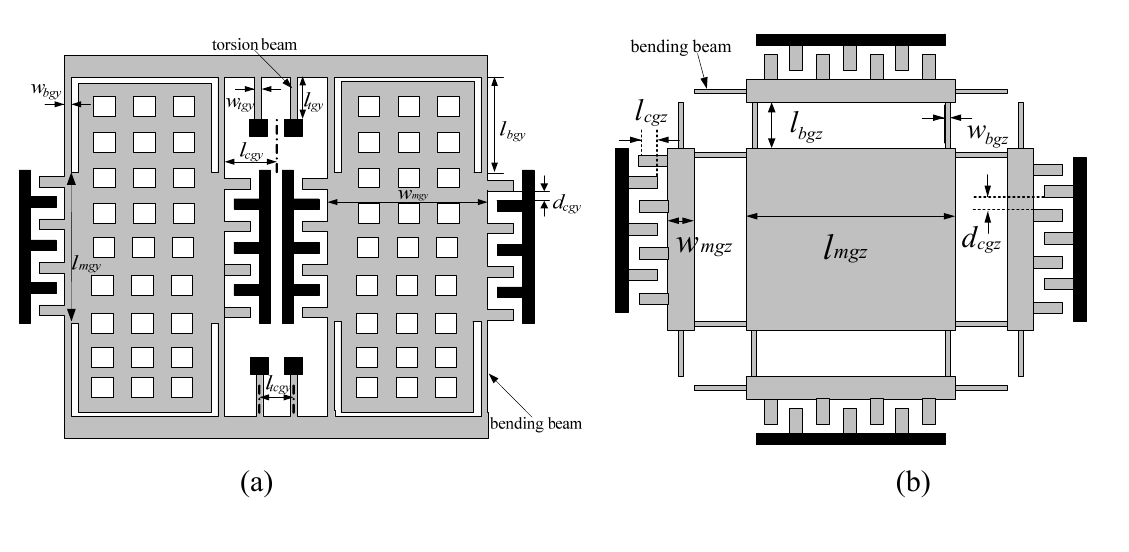
Figure 4. (a) X/Y-axis gyroscope topology in the two-chip MIMU. (b) Z-axis gyroscope topology in the two-chip